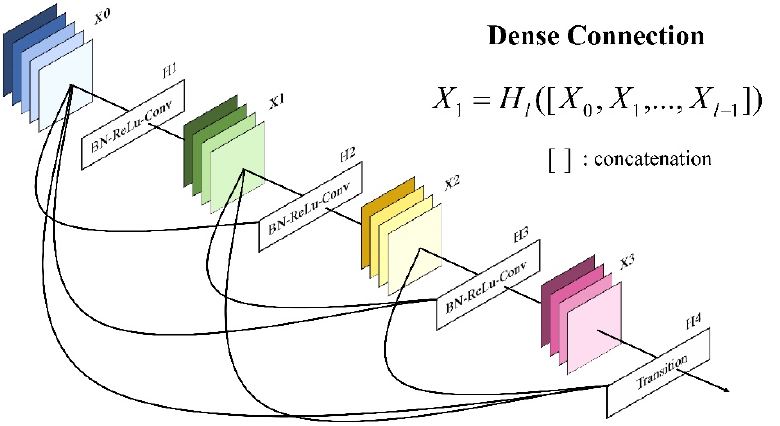
Figure 2. Multi-dimensional Dense Connection Module (BN refers to batch normalization, ReLU refers to rectified linear unit, Conv refers to convolution).